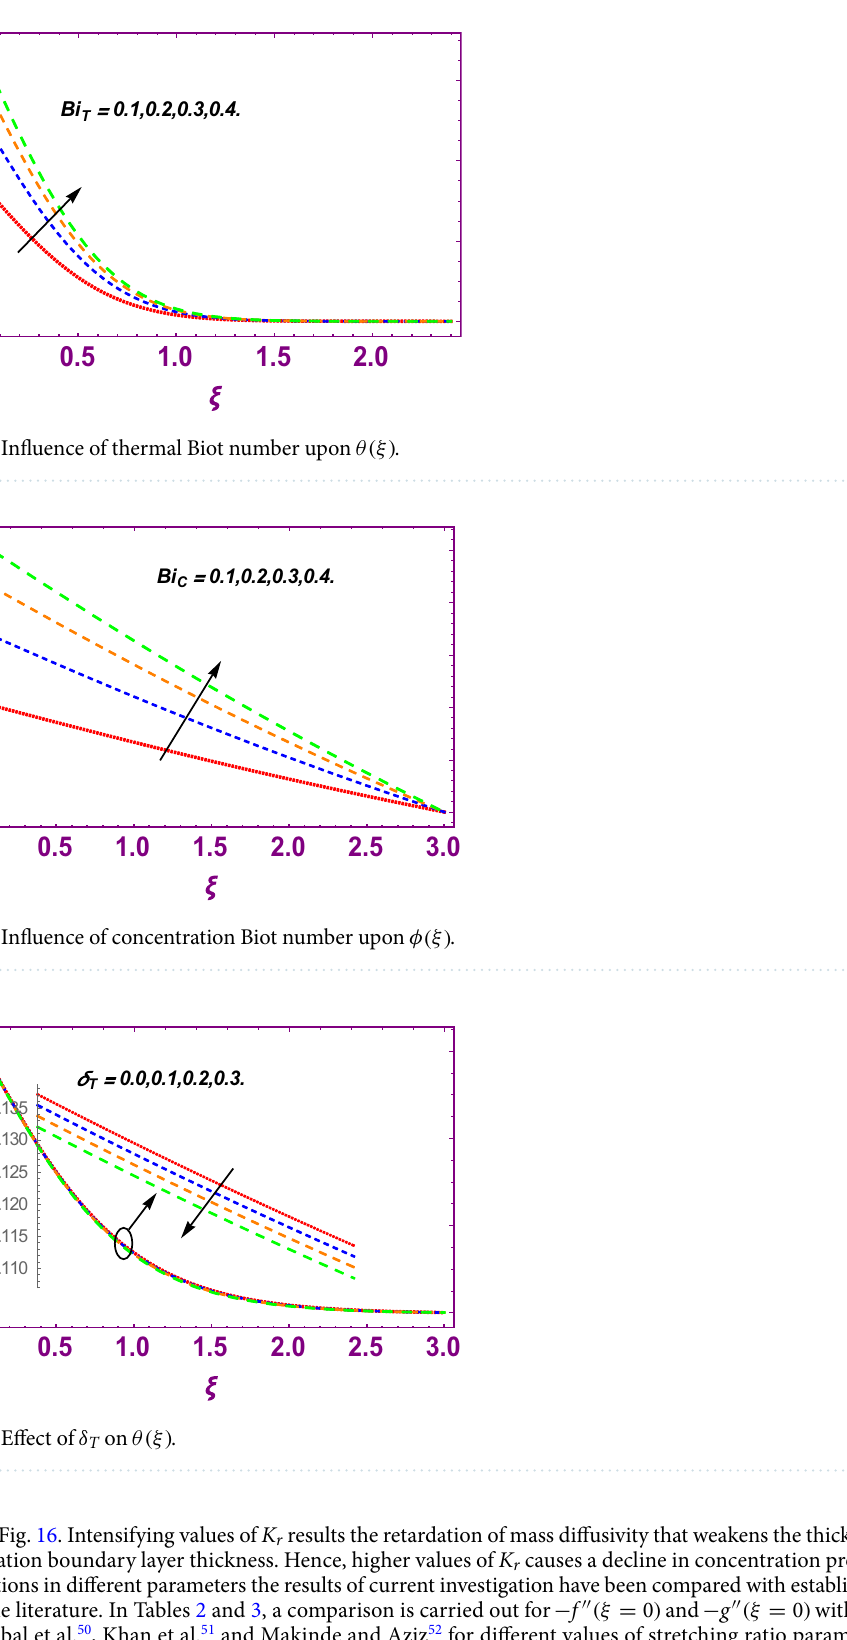
0 ) and 0 ) with the f ′′ (ξ g ′′ (ξ = = − −